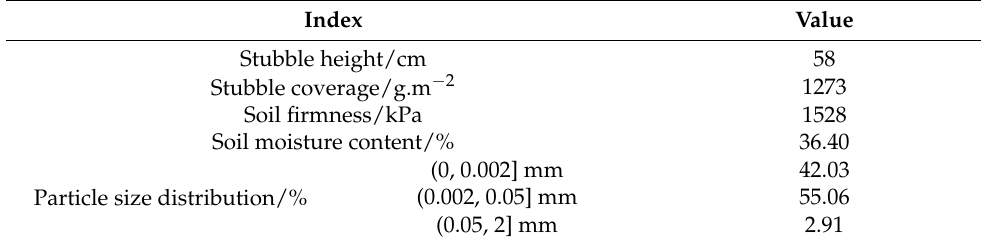
Table 2. Parameters of the field experiment conditions.